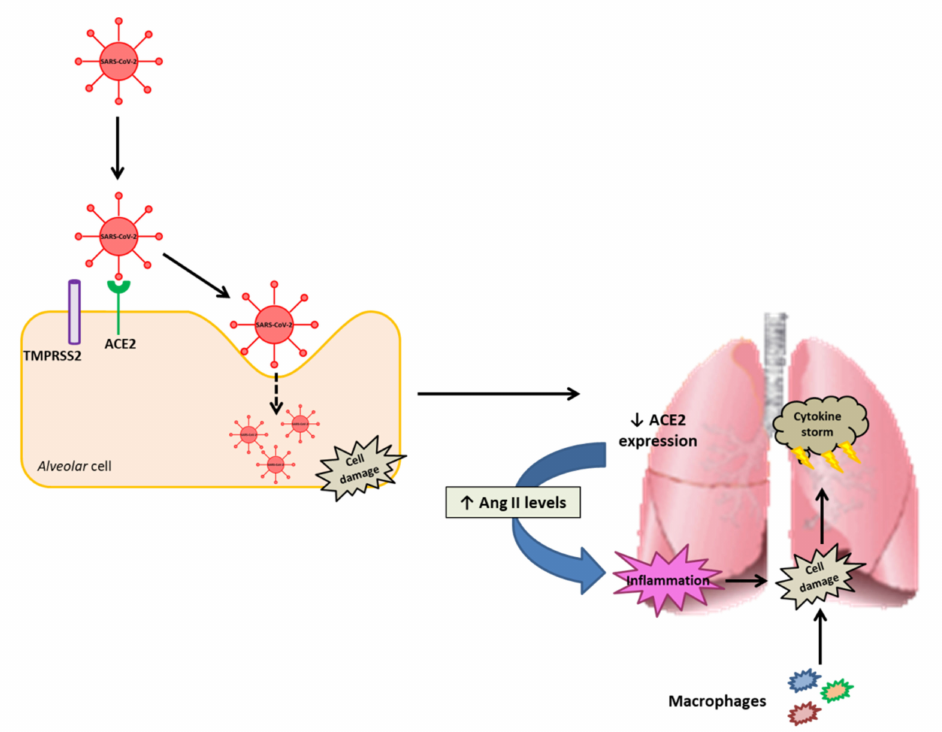
Figure 1. Summarised schematic representation of the SARS-CoV-2 viral infection process and derived outcomes in pulmonary tissue. ACE2: angiotensin-converting enzyme 2, Ang II: angiotensin II, TMPRSS2: transmembrane serine